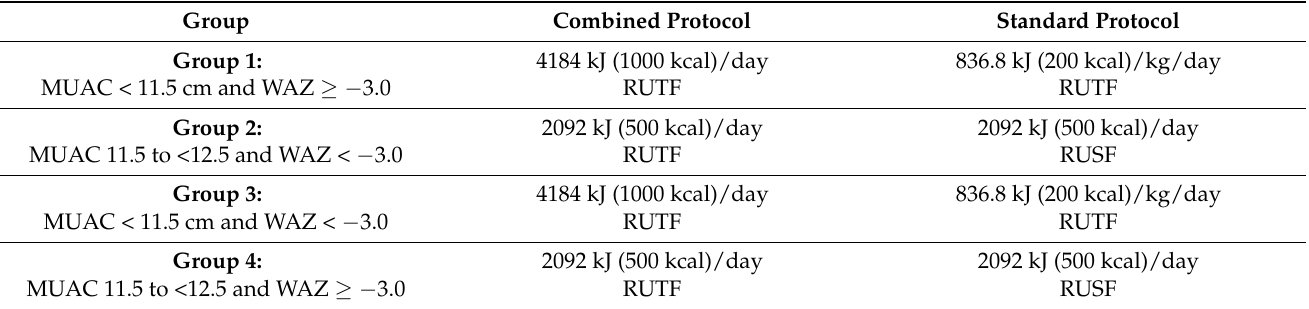
Table 1. Energy and food product given by treatment